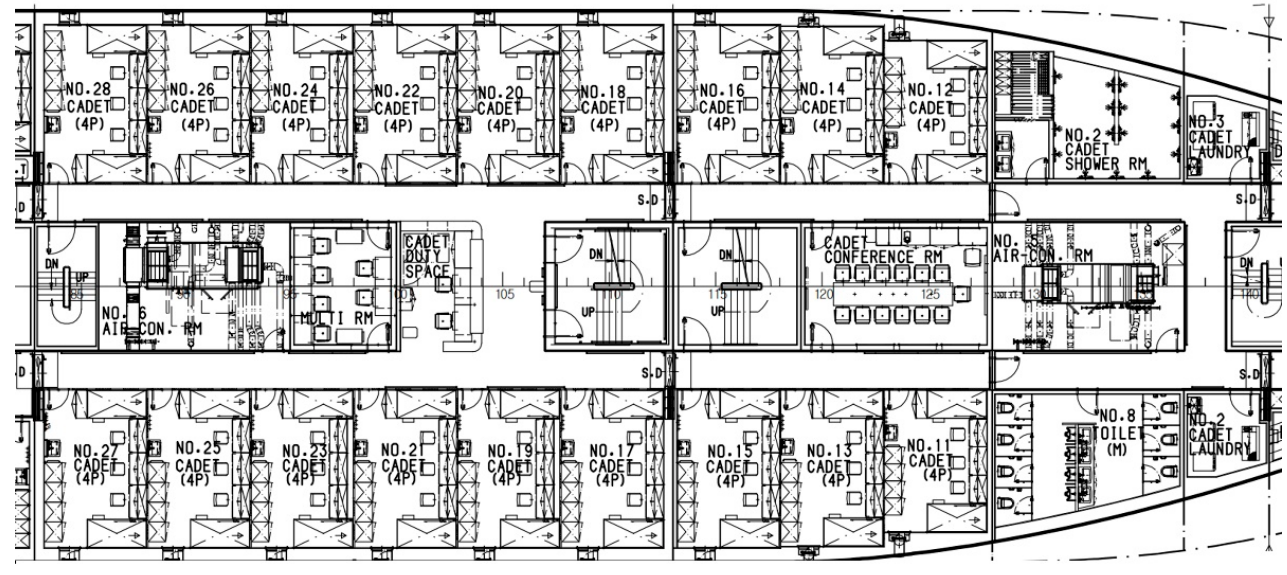
Figure 2. Floor plan of the HANNARA ship student housing quarters.